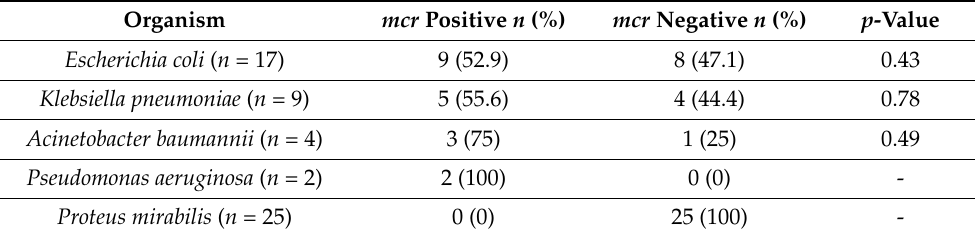
Table 2. Association between mcr genes and colistin-resistant (Col-R) bacterial strains ( n = 57).